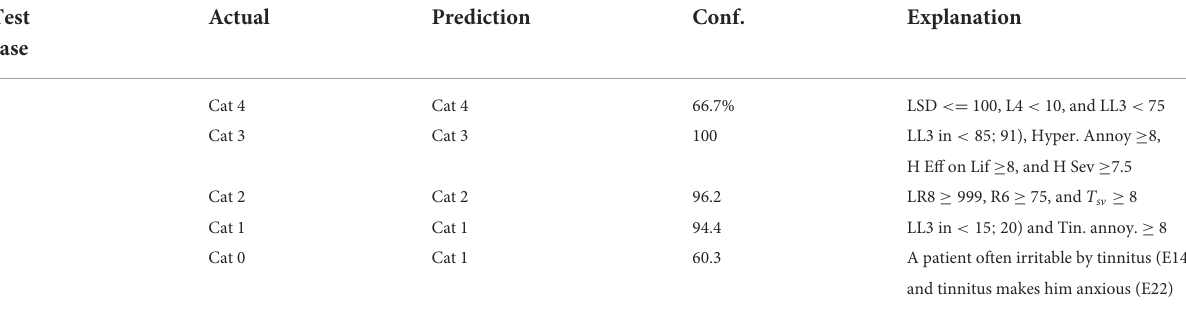
TABLE 8 Results on predicting diagnosis by the system on the chosen patient test cases—actual category vs. category predicted by the system, characterized by confidence, and explanation.